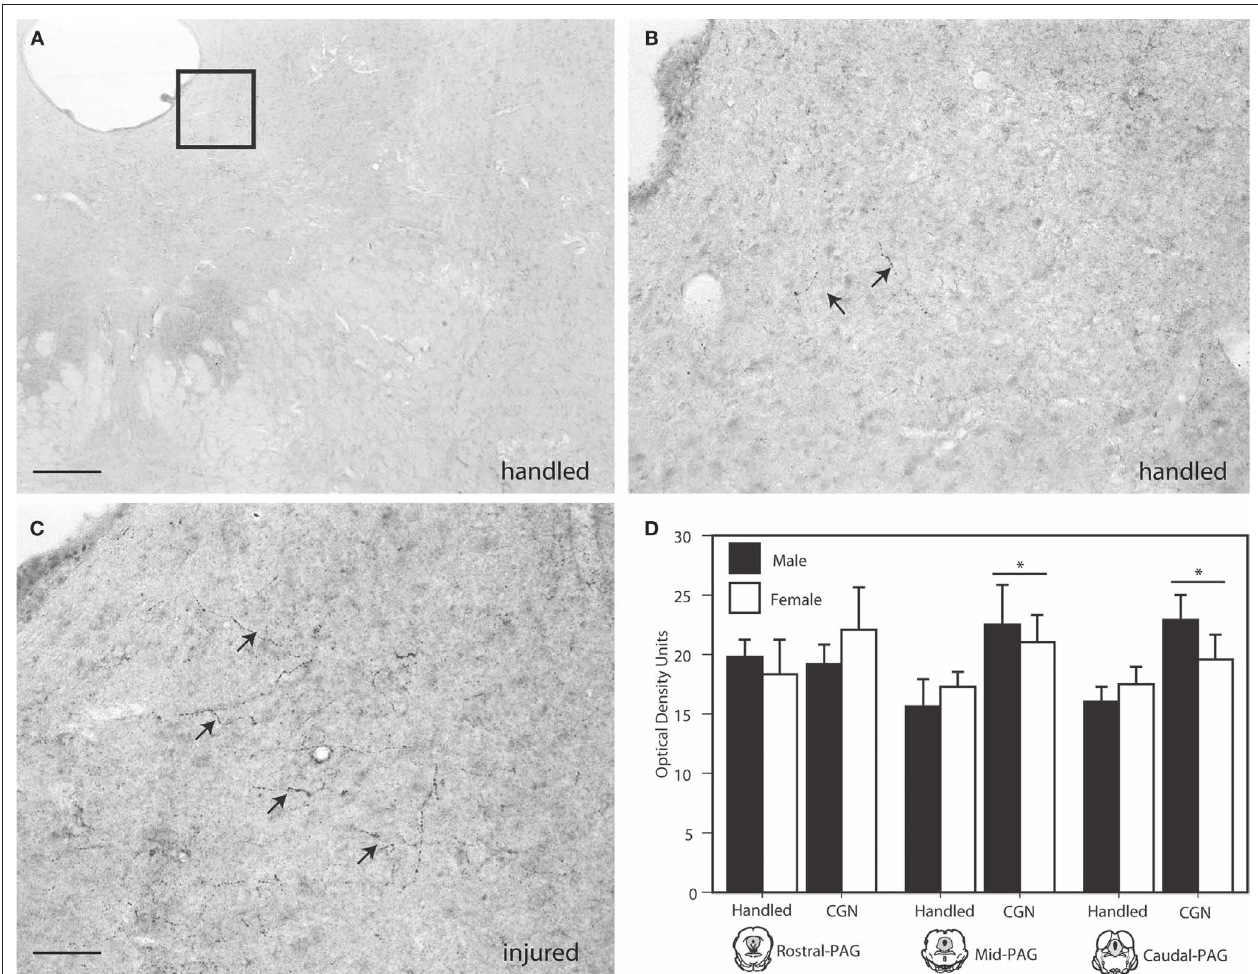
FIGURE 3 | Photomicrograph depicting representative examples of beta-endorphin-ir in the PAGl/vl in adult rats following neonatal treatment. (A) handled, 4 × , (B) handled, 20 × ; (C) 1% carrageenan, 20 × . (D) Neonatal CGN resulted in signifi cantly increased beta-endorphin-ir in the lateral/ventrolateral regions of the mid and caudal PAG compared to control animals. N = 6–8 rats per group/per sex. * denotes signifi cant main effect of treatment. Error bars represent